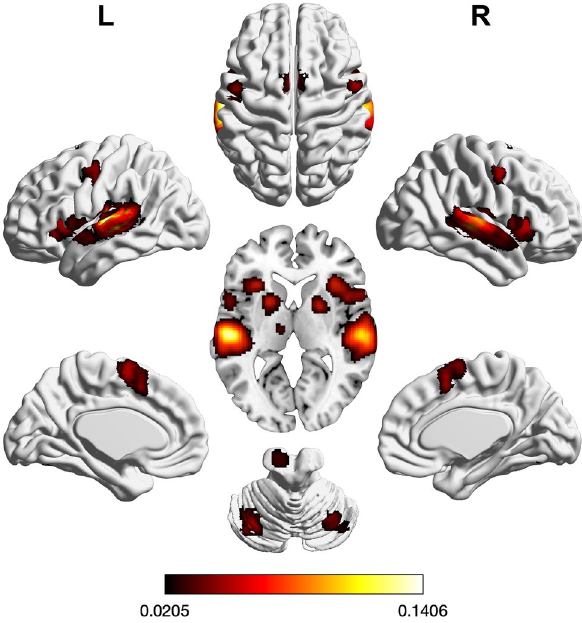
Figure 3. Foci of brain activity showing significant convergence of activity for auditory processes (cluster- level p < 0.05, family-wise error-corrected for multiple comparisons, cluster-forming threshold at voxel level: p < 0.001). The scale bar reflects activation likelihood estimation scores. Cortical and cerebellar clusters of convergence were visualized with the BrainNet Viewer 24 ; subcortical clusters were rendered on the individual anatomical template (“ch2better”) provided with MRIcron 25 .